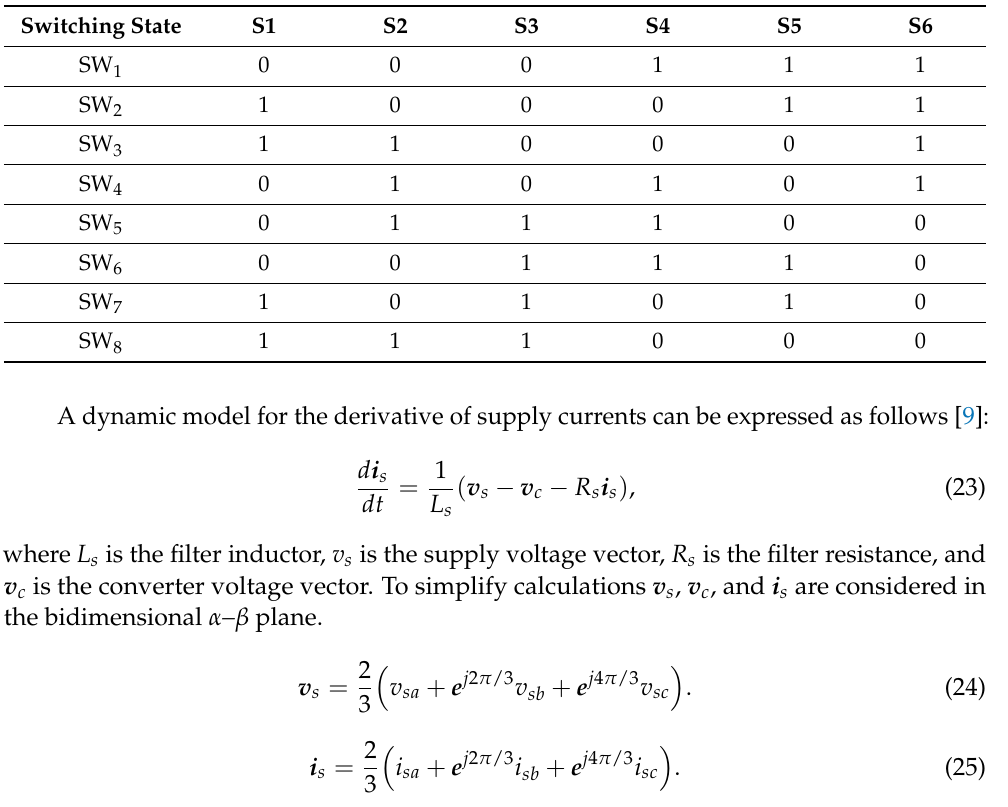
Table 1. The switching states in active rectifier.